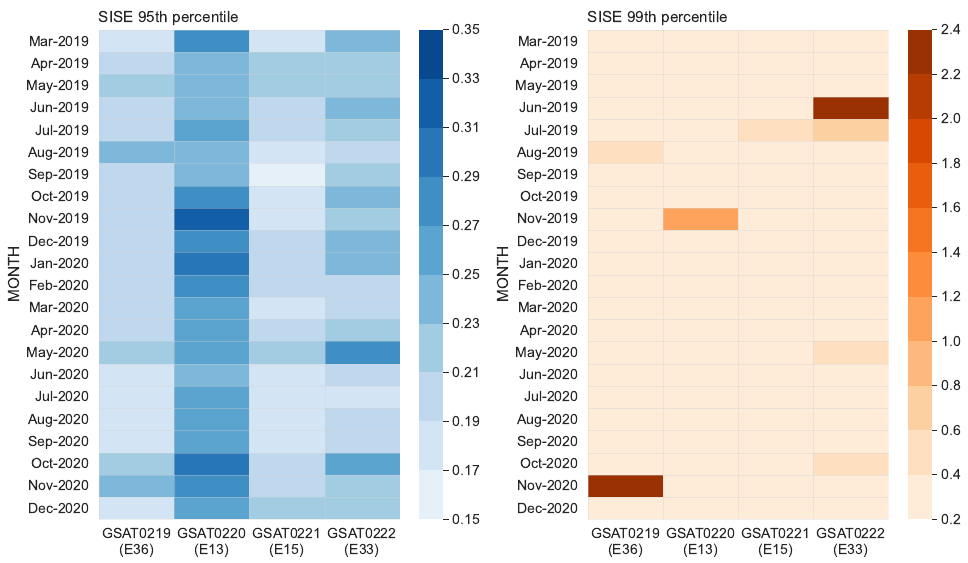
Figure 12. Signal-in-Space ranging accuracy expressed through two statistical indicators: 95th percentile ( left ) and 99th percentile ( right ) of the global average SISE time series for E1E5a signal. [Unit: meter].